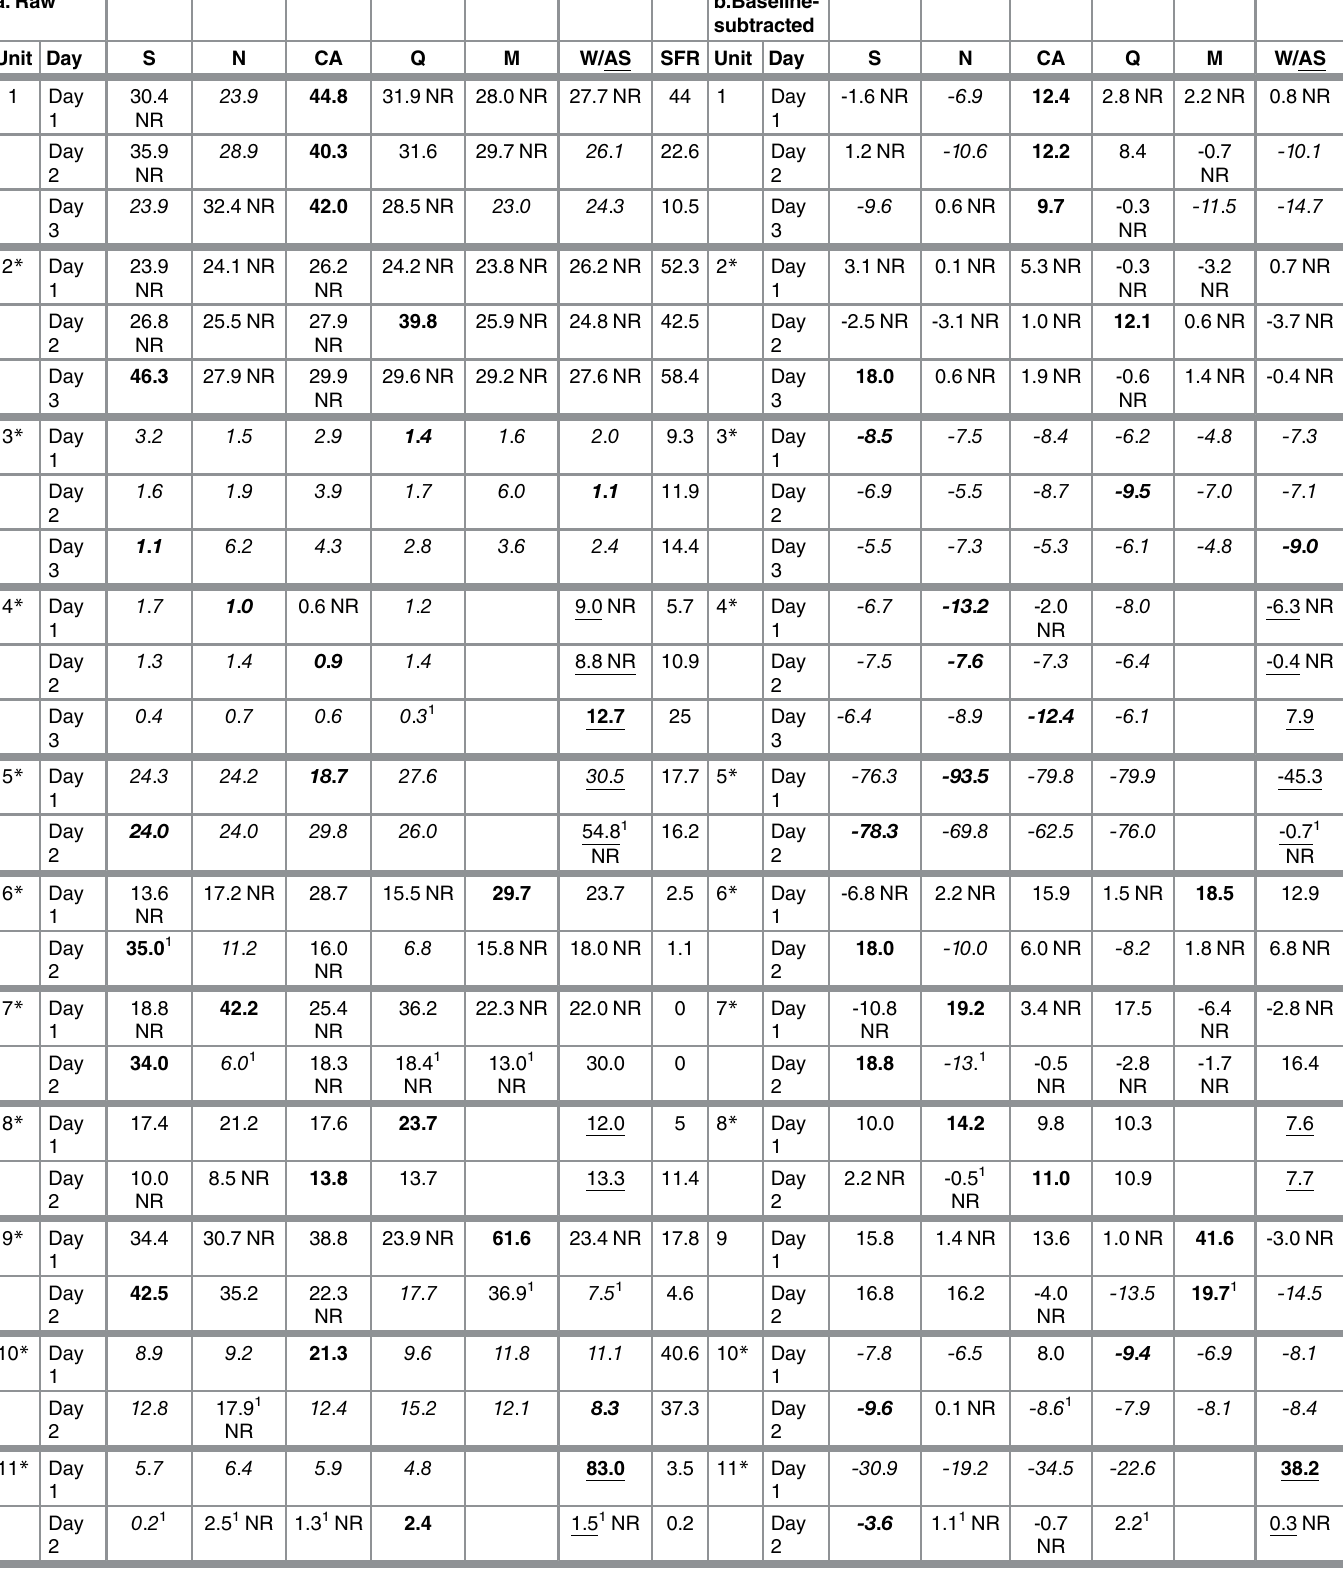
Table 1. Taste response magnitudes in spikes per sec (sps) in the NTS for taste stimuli of multiday recordings that met the “ same unit ” criterion. a. Raw b.Baseline-